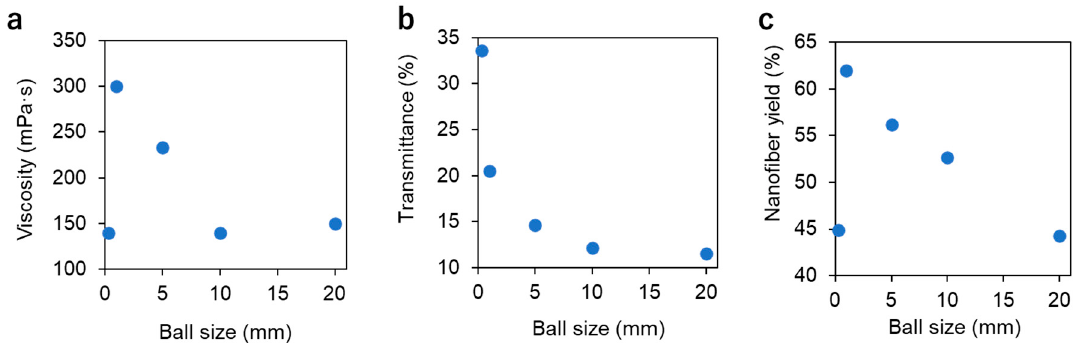
Figure 1. ( a ) Viscosity, ( b ) transmittance at 600 nm, and ( c ) nanofiber yield after milling of chitin using different ball sizes.